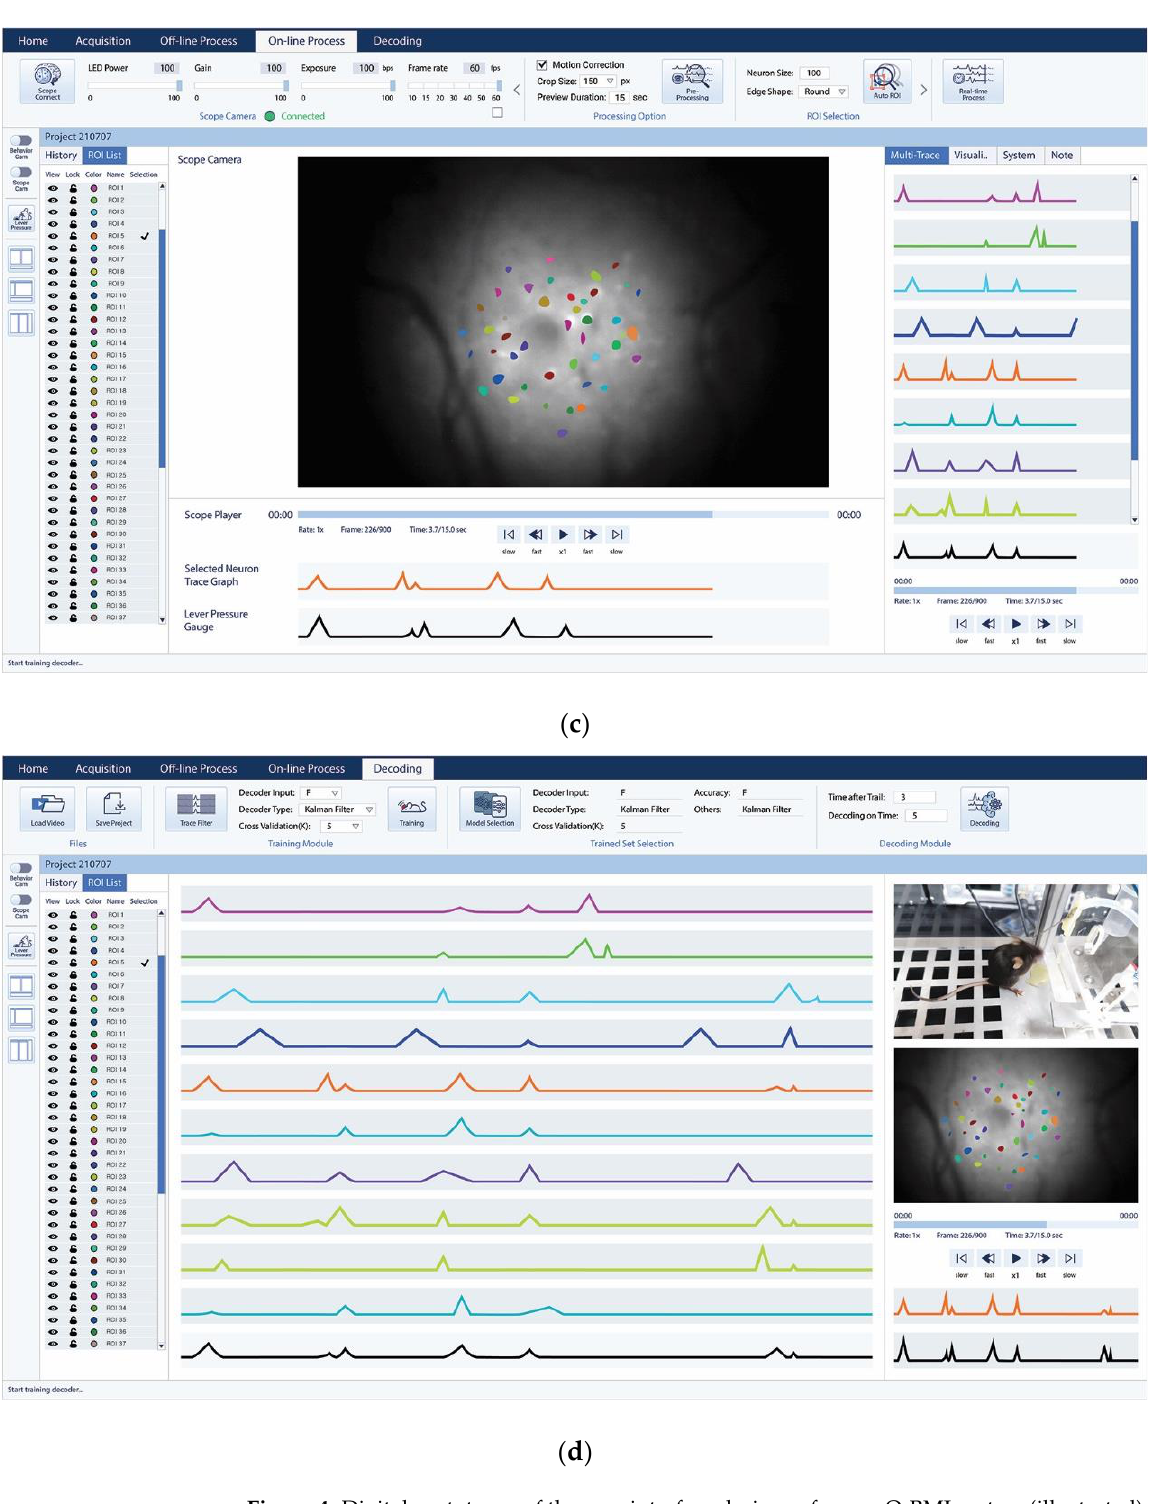
Figure 4. Digital prototypes of the user interface designs of a new O-BMI system (illustrated). ( a ) data acquisition; ( b ) offline processing; ( c ) online processing; ( d ) decoding.